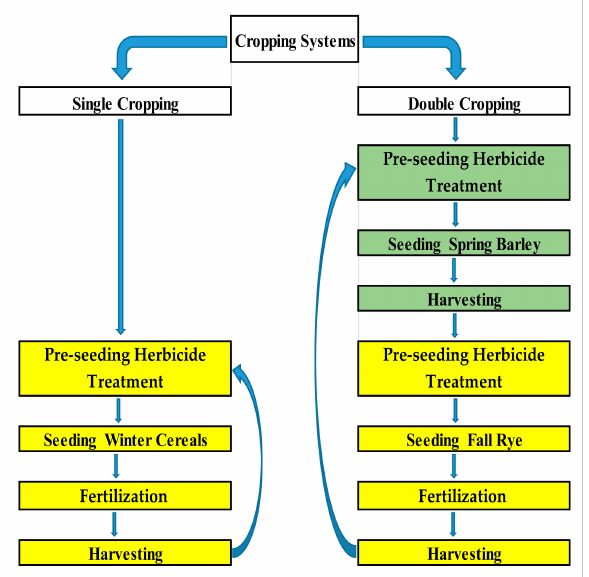
Figure 2. A flowchart showing the sequence of the work both in single and double cropping systems. Green box represents barley and yellow box represents winter cereals agronomics.